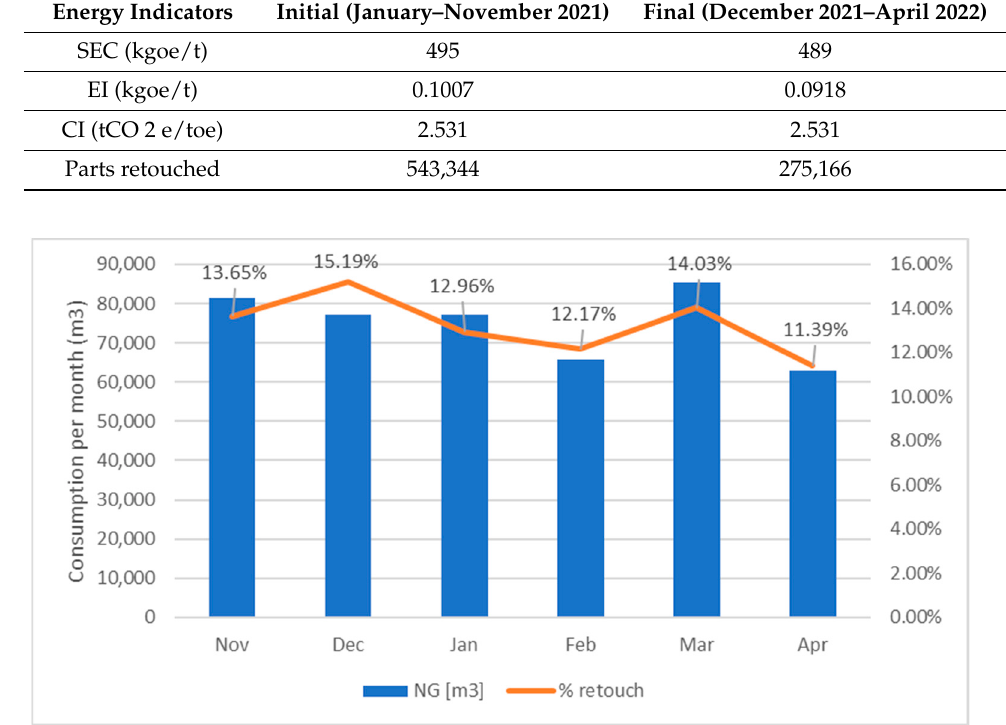
Table 7. Comparison of energy indicators at the beginning and end of this study. Energy Indicators